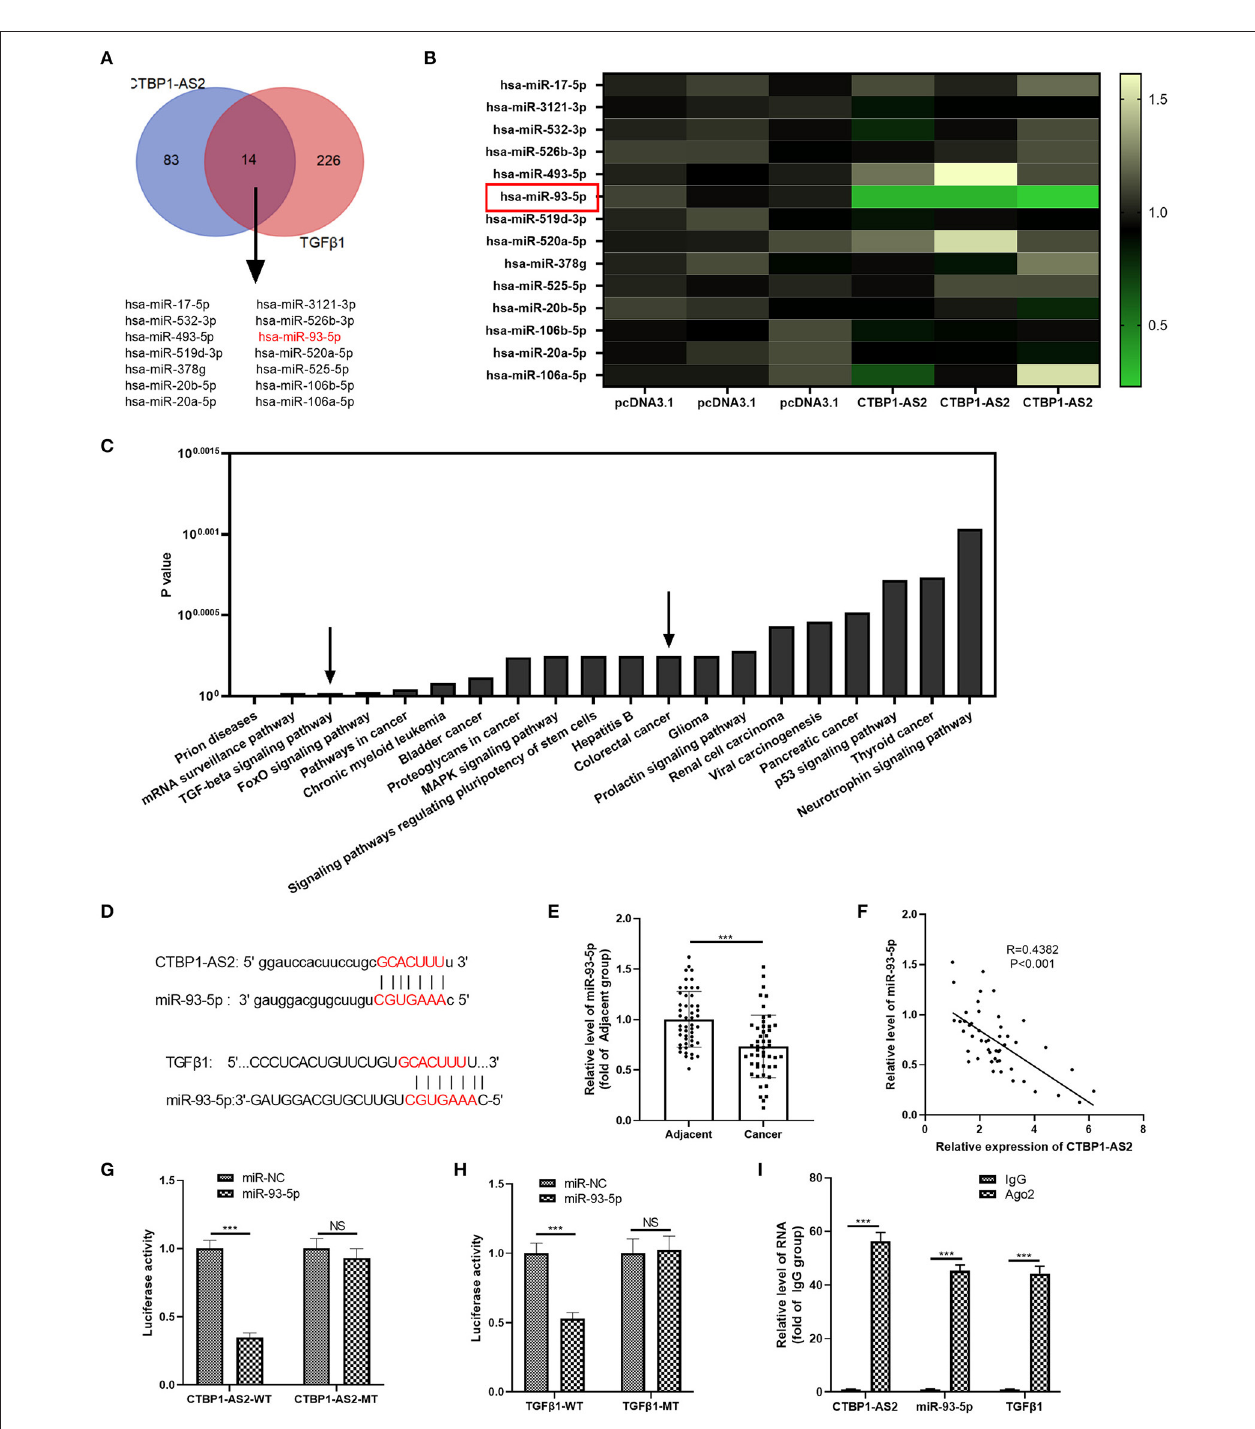
FIGURE 5 | miR-93-5p as a potential target for CTBP1-AS2 and TGF- β 1. (A) Prediction of miRNAs targeting CTBP1-AS2 by Starbase (http://starbase.sysu.edu.cn/), prediction of miRNAs targeting TGF- β 1 by TargetScan (http://www.targetscan.org/vert_72/), use of Venn diagram to analyze the common miRNA of the two. Fourteen potential miRNAs were found. (B) Detection of the 14 miRNAs in SW620 cells transfected with CTBP1-AS2 or pcDNA3.1 by performing RT-PCR. (C) Analysis of the signal pathways involved in miR-93-5p through mirPath version 3. (D) Base pairing sites of miR-93-5p with CTBP1-AS2 and TGF- β TGF- β 1 are shown. (E) Detection of miR-93-5p expression in CRC tissues and the adjacent normal tissues by RT-PCR. (F) Analysis of the correlation between miR-93-5p and CTBP1-AS2 in CRC tissues by Pearson’s linear regression. (G,H) Use of dual-luciferase activity experiments to verify the binding relationship of miR-93-5p to CTBP1-AS2 (G) and TGF- β 1 (H) . (I) Use of RIPA lysis buffer to verify the relationship of miR-93-5p, CTBP1-AS2, and TGF- β 1. Performing the RT-PCR to detect the levels of CTBP1-AS2, miR-93-5p, and TGF- β 1 in RIPA precipitates. *** p < 0.001. N = 3. CRC, colorectal cancer; miRNA, microRNA; NS, not significant; RIPA, radioimmunoprecipitation assay; RT, reverse transcription; TGF- β , transforming growth factor- β